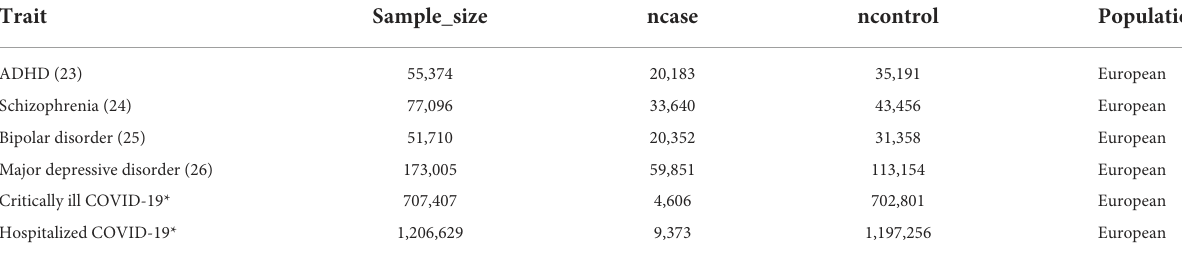
TABLE 1 Psychiatry diseases and COVID-19 genetic summary data